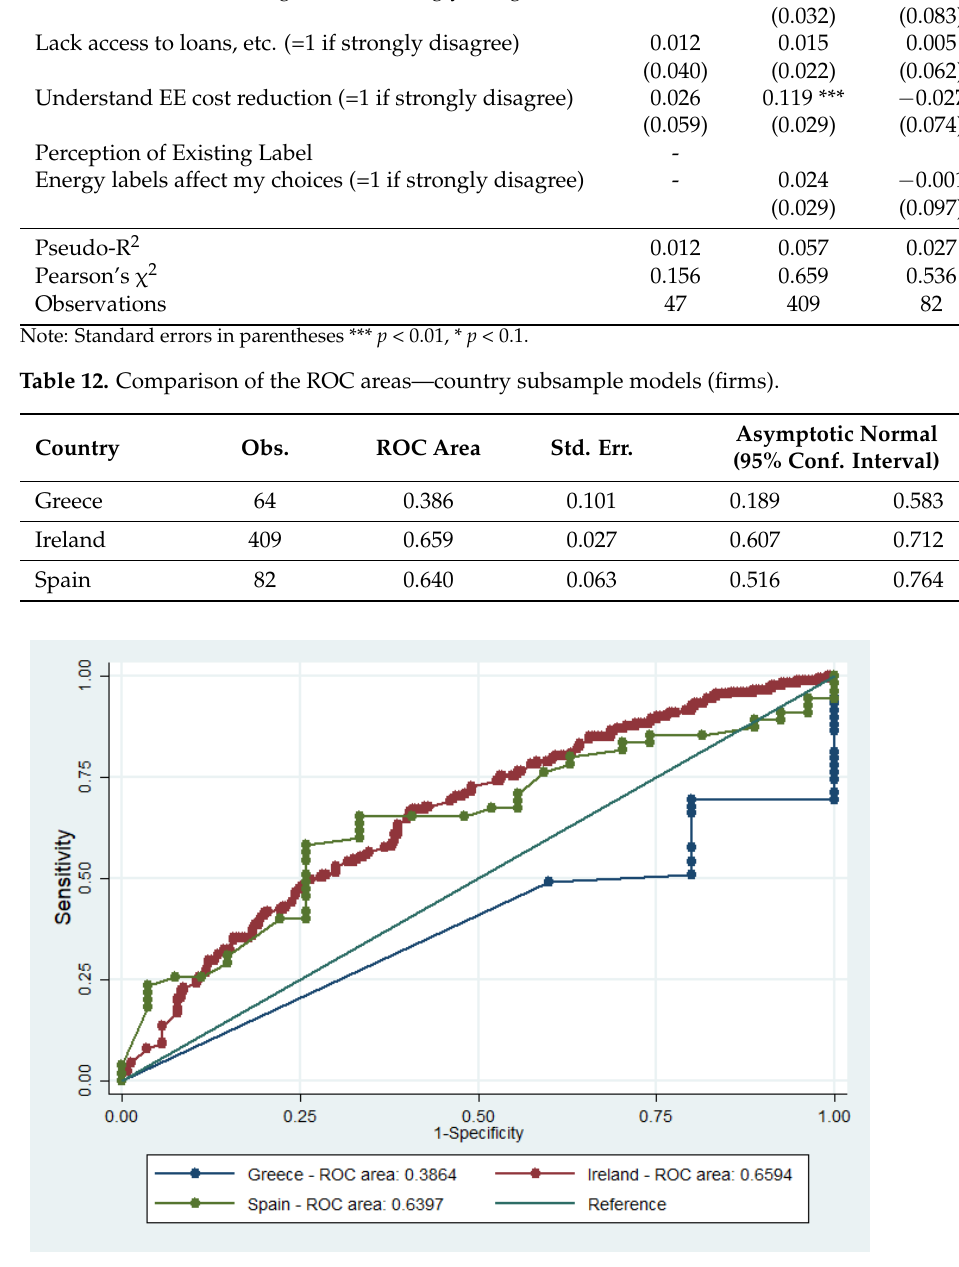
Figure 5. ROC curves and C-statistic estimates for the national models (firms).